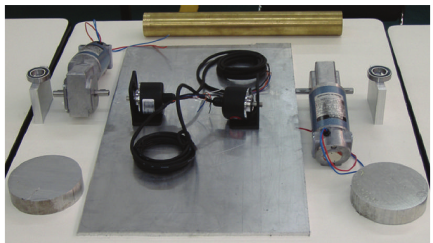
Figure 2: Materials used for the prototype